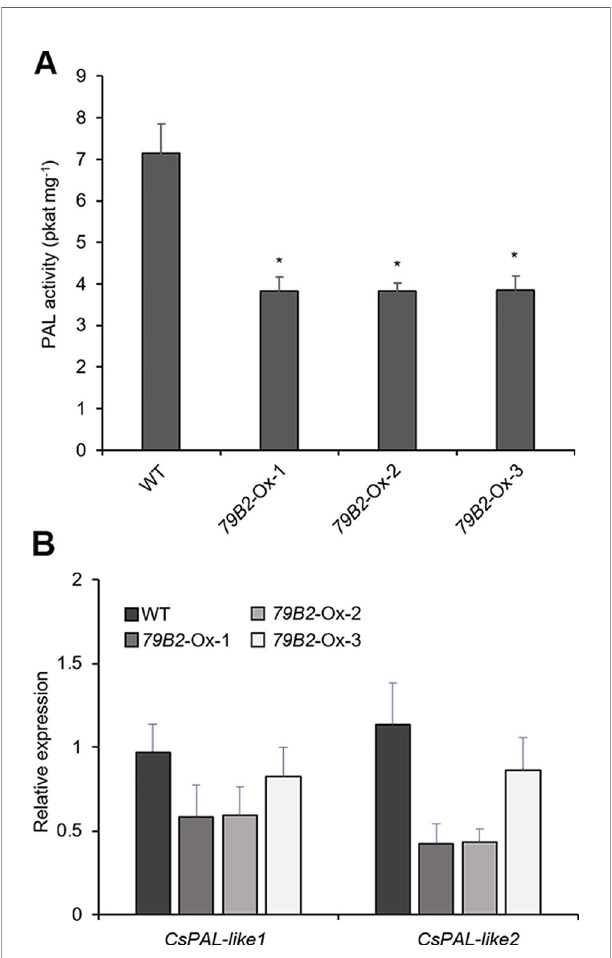
FIGURE 4 | Phenylalanine ammonia lyase (PAL) activity is reduced in AtCYP79B2 overexpression lines. (A) PAL activities were measured using crude extracts of leaves from 2-week-old soil grown Camelina plants. (B) Transcript abundance of Camelina PALs in transgenic lines and wild type was measured with quantitative RT-PCR. CsPAL-like1 represents expression of six genes (Csa06g039710, Csa05g016810, Csa04g050600, Csa06g027730, Csa04g039260, and Csa09g061550) which are Arabidopsis PAL1 and PAL2 homologs. CsPAL-like2 represents expression of Csa01g011180 and Csa15g012820, which are Arabidopsis PAL4 homologs. In (A) and (B) , data represent mean ± SE of three independent experiments. * represents P < 0.05 (two-tailed student ’ s t-test) when compared with wild type.